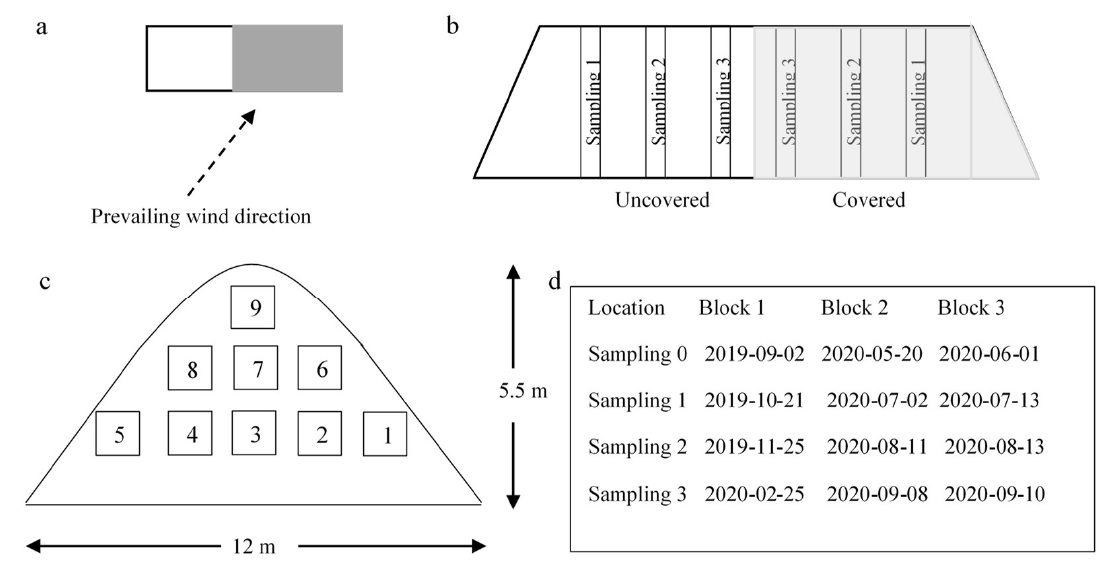
Figure 2. ( a ): Orientation of stacks, showing the prevailing wind direction, ( b ): sampling sections and order of resampling and ( c ): cross-section of the experimental stacks, showing sampling points. TinyTags ® temperature sensors were placed at sampling points 7 and 9, ( d ): sampling time. Table 2. Standards used for sampling, sample preparation, classification and determination of fuel